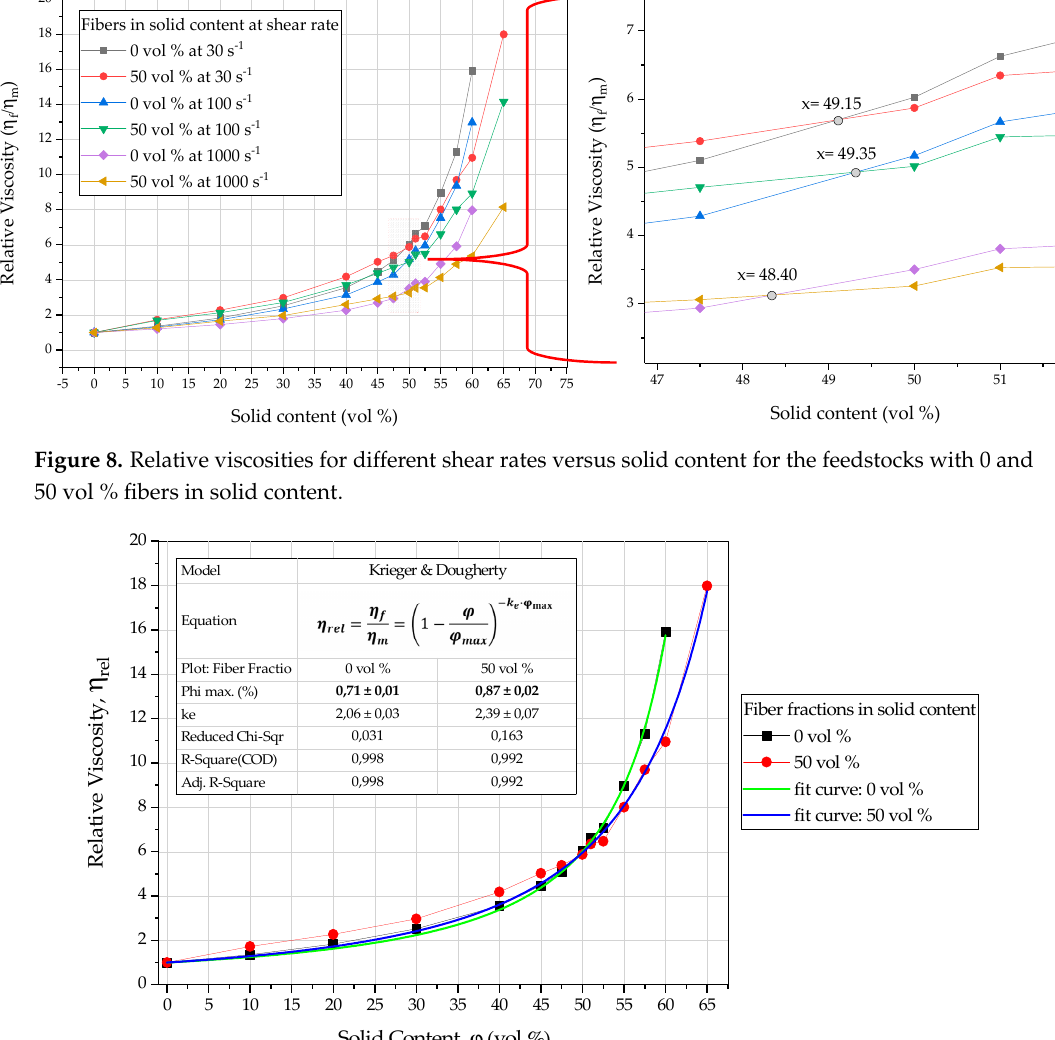
Figure 9. Application of Krieger and Dougherty model for defining the maximum possible solid content in the feedstocks with 0 and 50 vol % fibers in solid content.